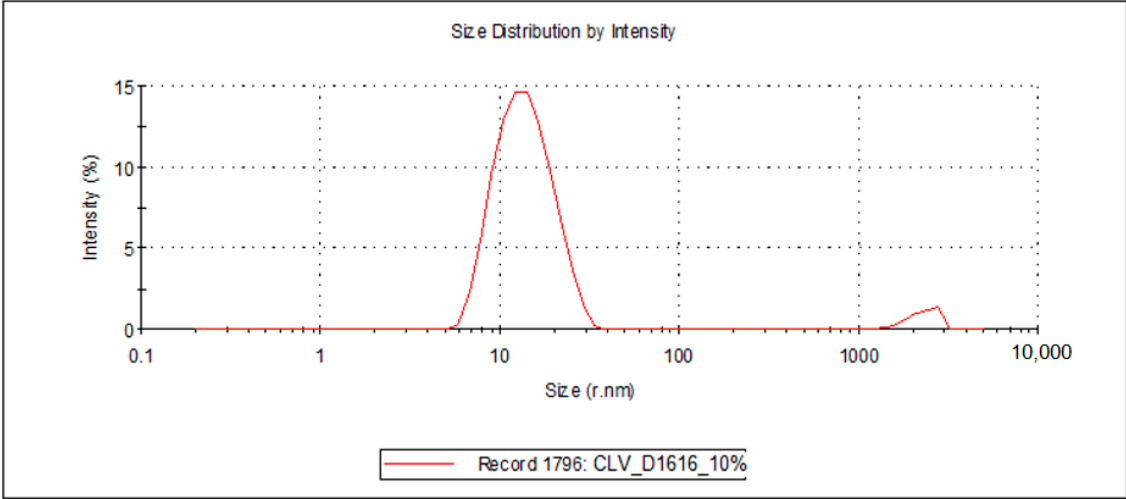
Figure 6. Droplet size distribution of the FZ-loaded microemulsions based on clove essential oil and sucrose palmitate.